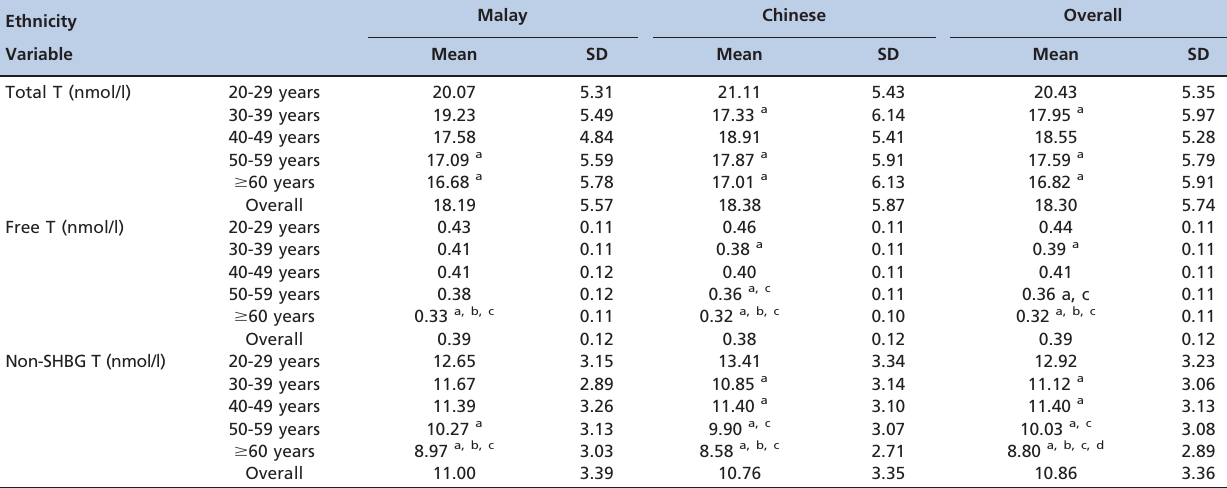
Table 3 - Testosterone levels between Malay and Chinese